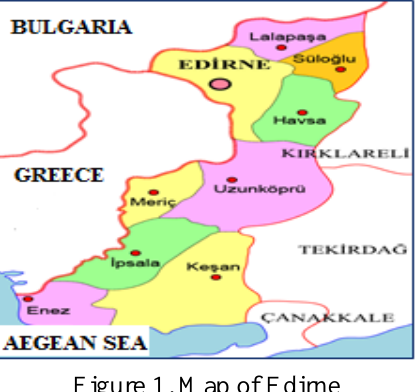
Figure 1. Map of